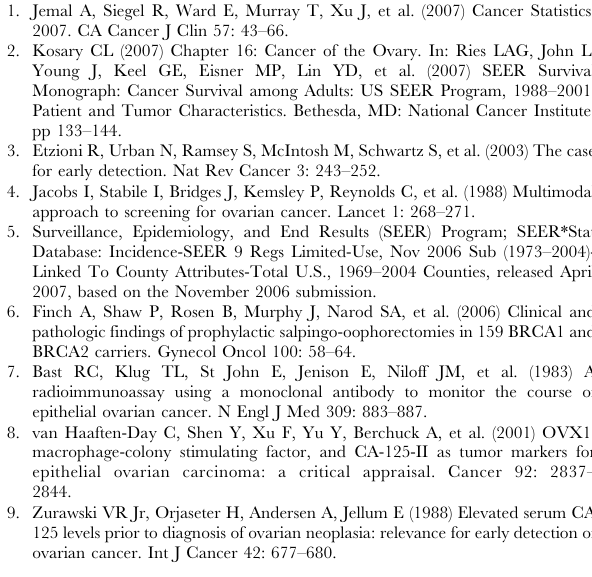
Table S1 Detailed assay conditions for in-house bead-based assays for MUC16 (CA125), WFDC2 (HE4) and MSLN (mesothelin).